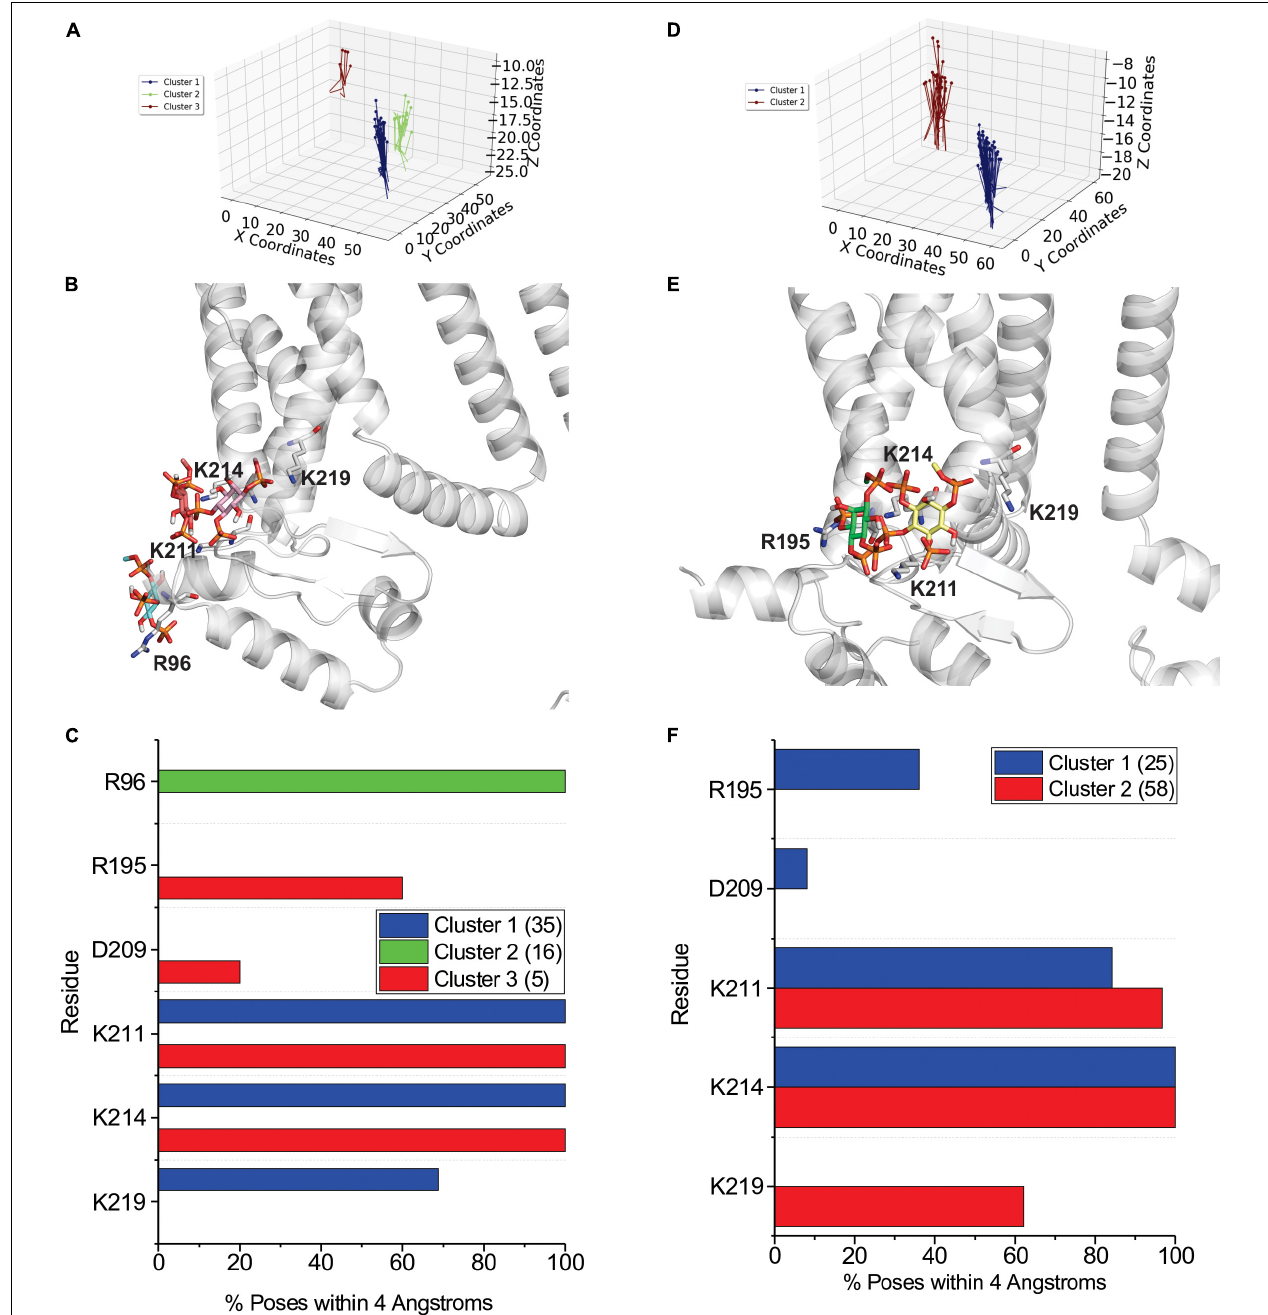
FIGURE 3 | Docking of PI(4,5)P 2 and PI(3,4,5)P 3 to HCN1 channels with VSDs in the down (activated) conformation. (A) The results from 500 attempts to dock PI(4,5)P 2 headgroups to HCN1 (PDB: 6UQF). Poses were accepted based on orientation and clusters were identified in an automated manner using MultiCluster software previously described (Tanguay et al., 2019). (B) Binding sites of the most representative poses for each cluster (C) The frequency of residues within 4 Å of the PI(4,5)P 2 ligand for each pose was assessed and is indicated as a percentage of the accepted poses. (D) The results from 500 attempts to dock PI(3,4,5)P 3 headgroups to HCN1. (E) Binding sites of the most representative poses for each cluster (F) The frequency of residues within 4 Å of the PI(3,4,5)P 3 ligand for each pose was assessed and is indicated as a percentage of the accepted